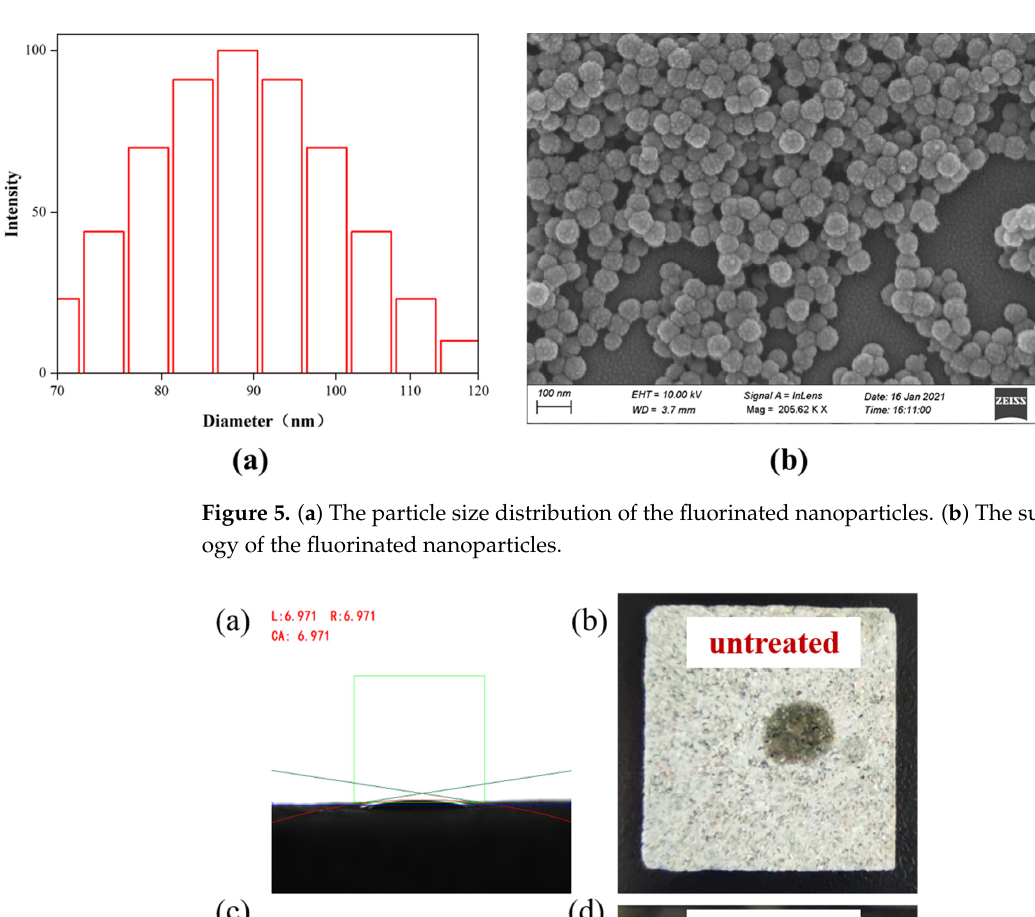
Figure 5. ( a ) The particle size distribution of the fluorinated nanoparticles. ( b ) The surface morphol ‐ ogy of the fluorinated nanoparticles.